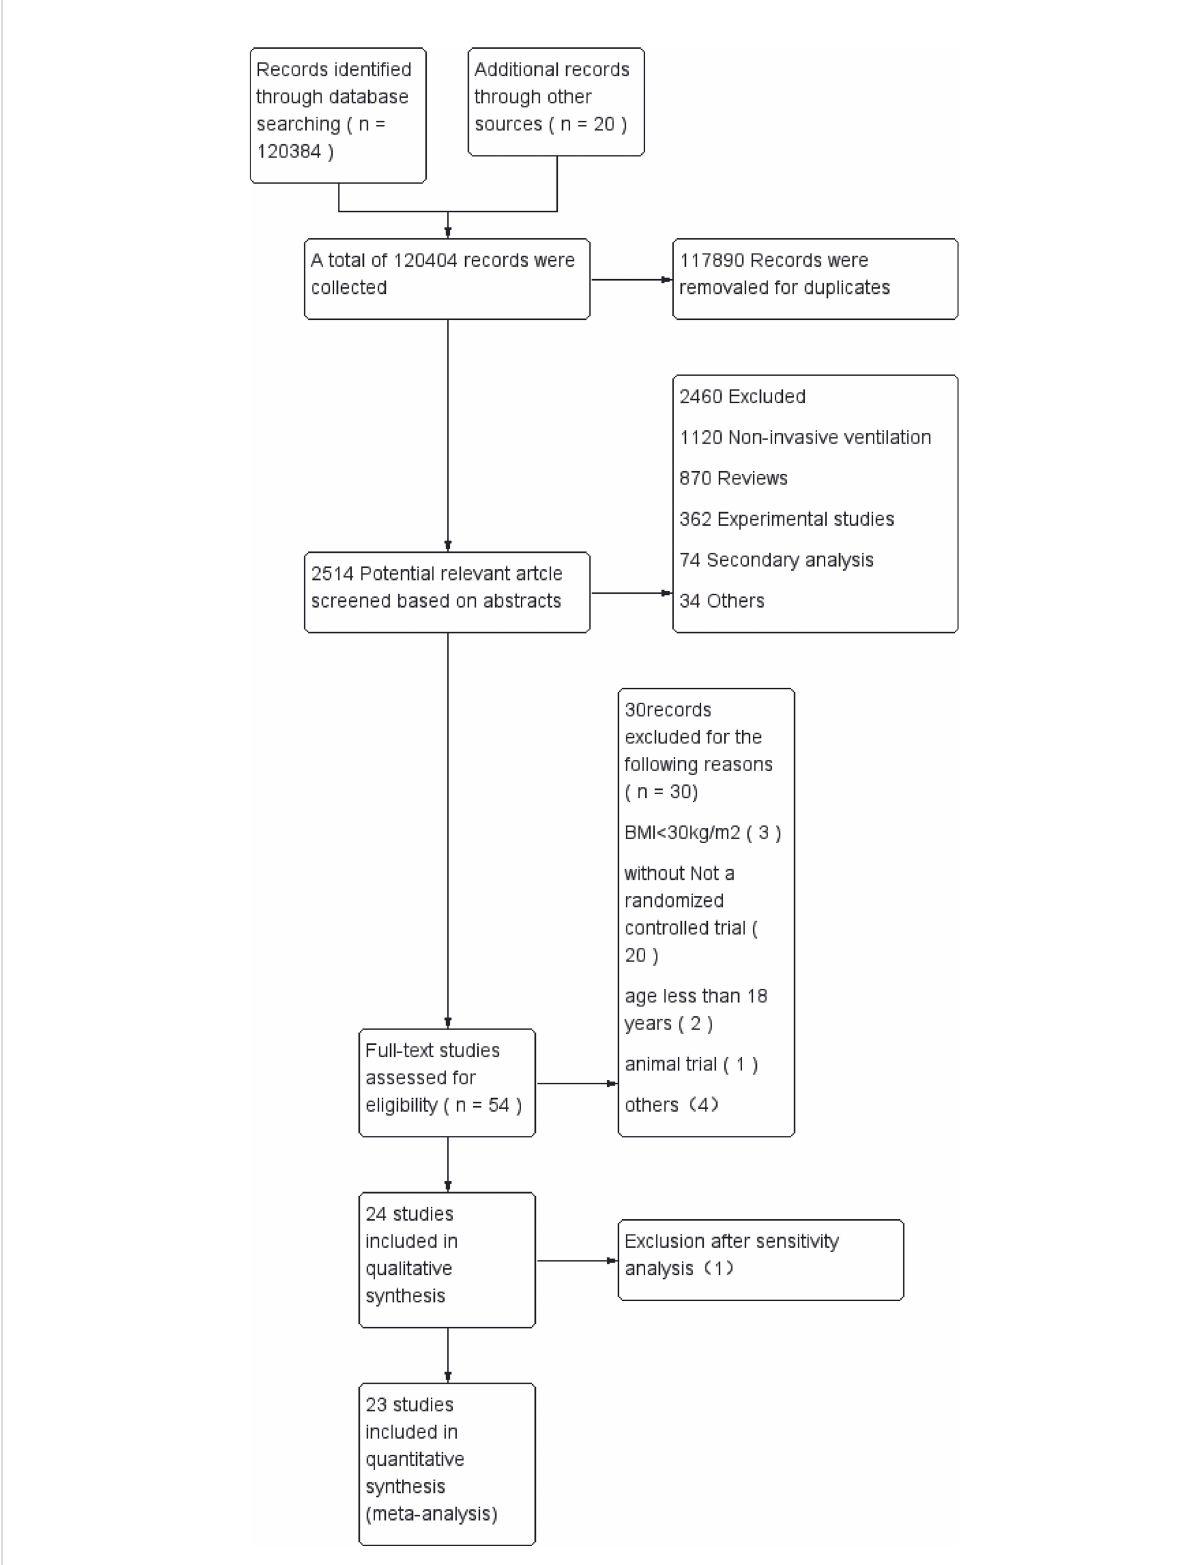
FIGURE 1 Flow chart of literature